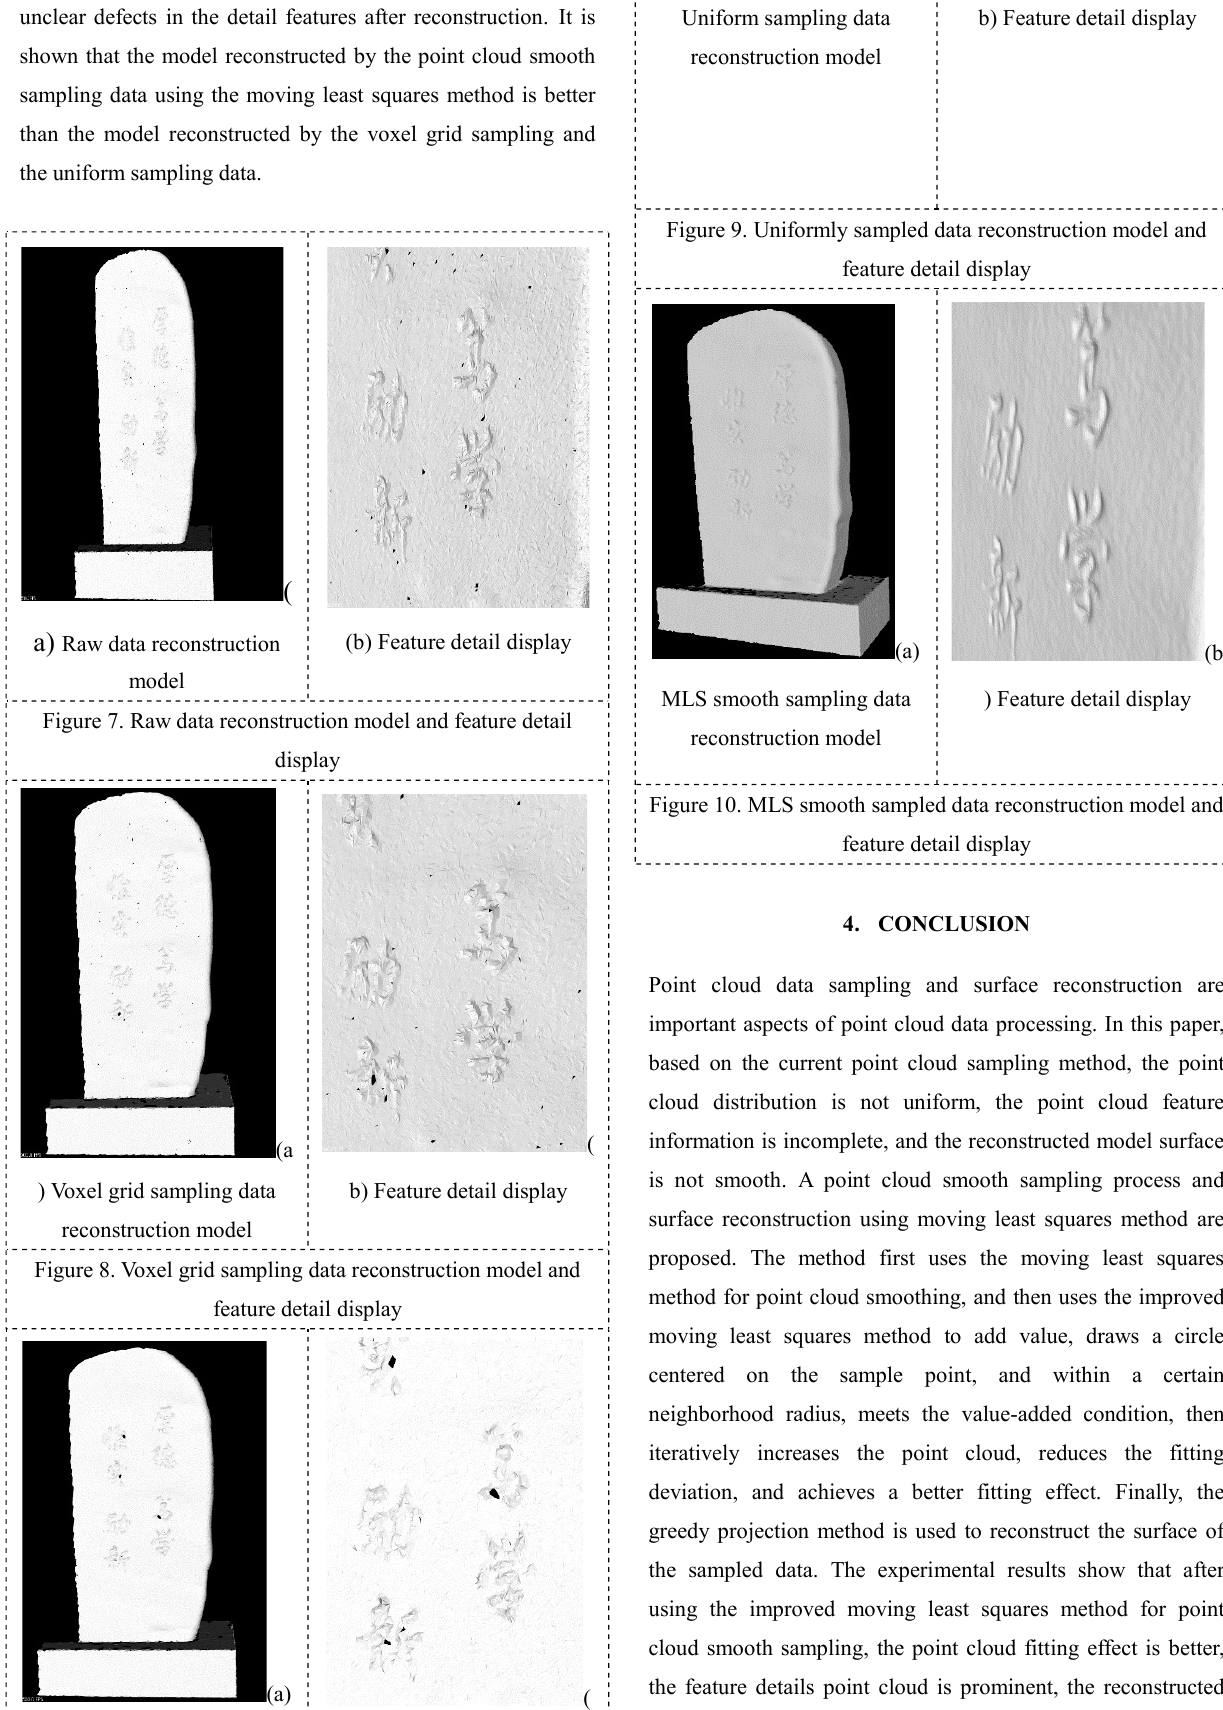
Figure 7. Raw data reconstruction model and feature detail